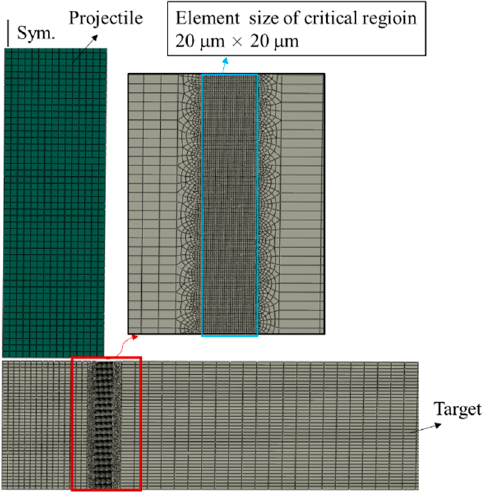
Figure 8. Finite element model with a mesh size of 20 × 20 μ m 2 for the target and the